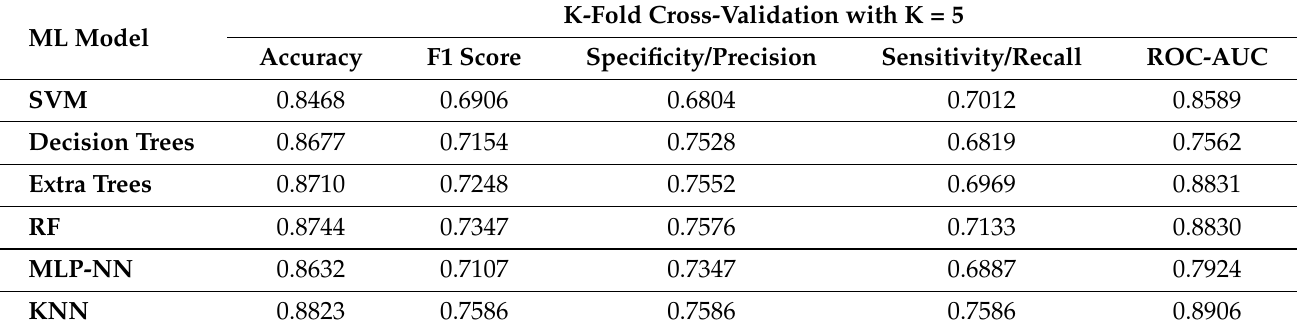
Table 8. Average results of K-fold cross-validation with K = 5 of the ML models trained on